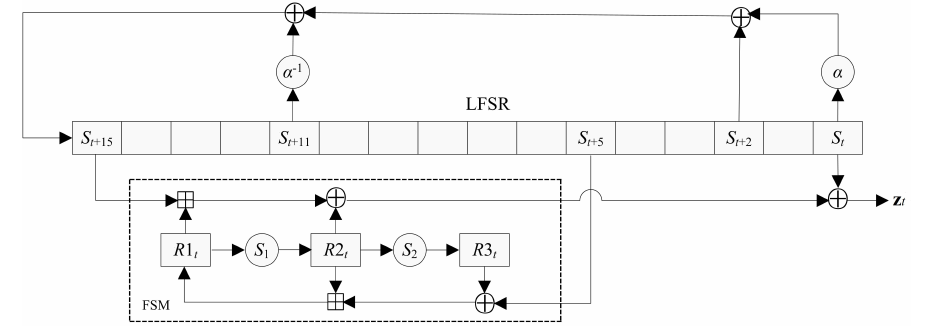
Figure 2: The keystream generation phase of SNOW